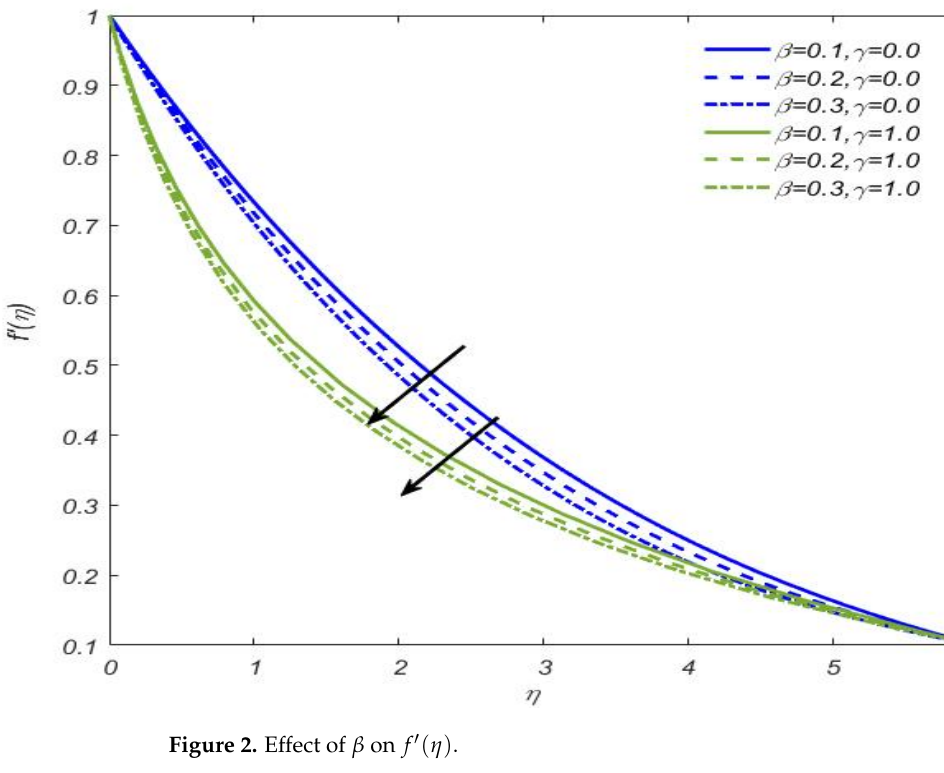
Figure 2. Effect of  on